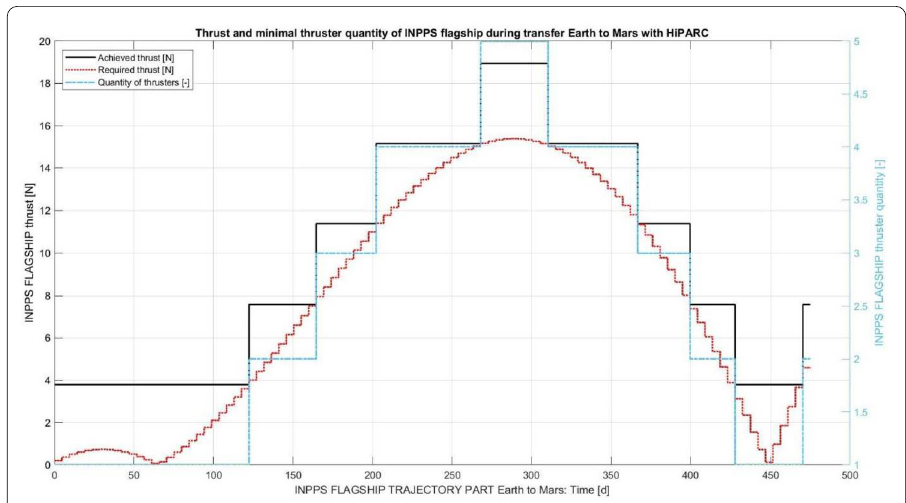
Figure 2 Plot of required and achieved thrust of HiPARC over mission time of transfer to Mars. In addition, the corresponding thruster quantity is shown in blue